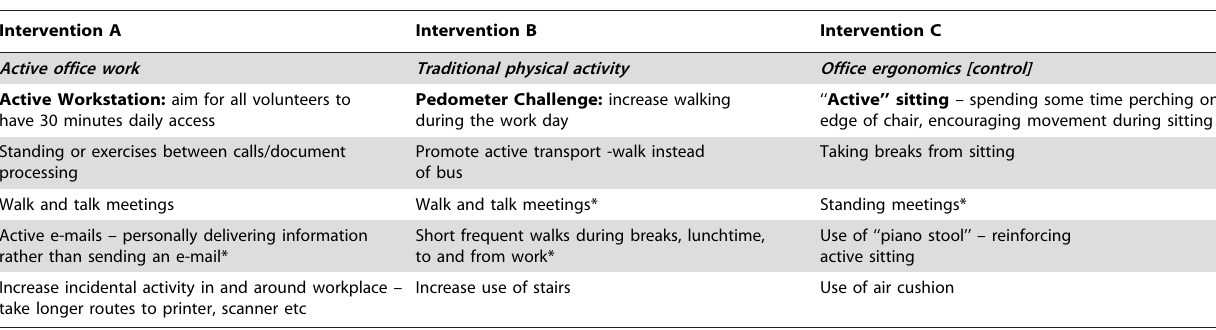
Table 1. List of group determined interventions.